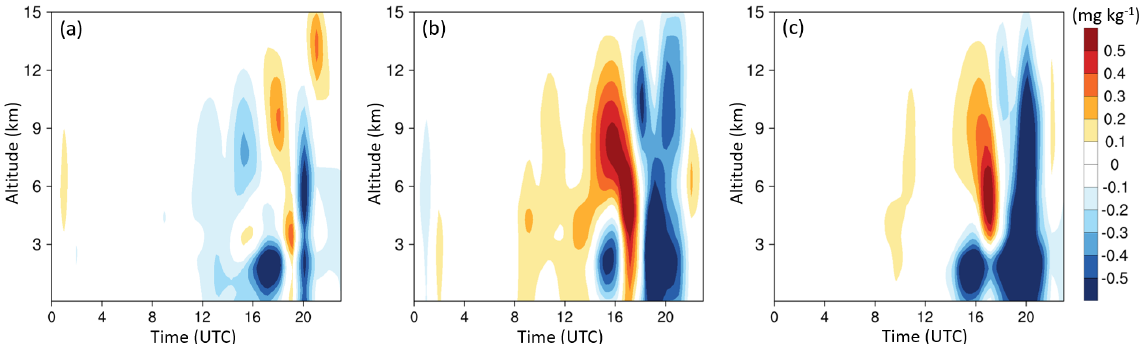
Figure 8. Diurnal variation in the vertical distribution of the domain-averaged difference in precipitating hydrometeor (QRAIN+QSNOW+QGRAUP) concentrations caused by BB aerosols’ (a) ACI, (b) ARI, and (c) total effect in the EMIS1 emission sce-